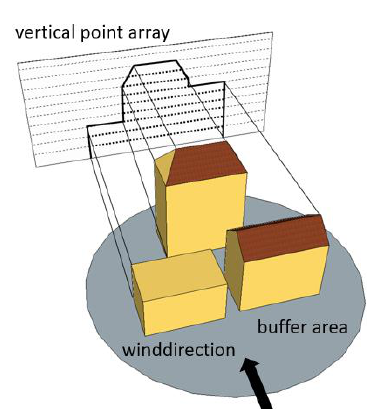
Figure 4. ‘Frontal area index’ calculation (FAILoD2_real) within a buffer using LoD2 data.